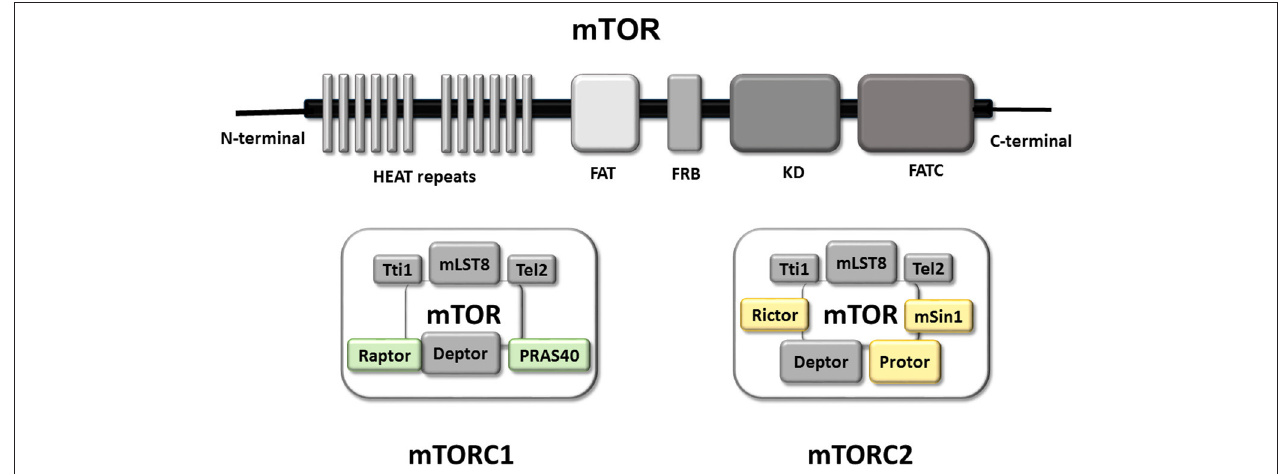
FIGURE 1 | mTOR Functional domains and composition of mTORC1 and mTORC2. Graphical representation of the main functional domains of mTOR protein. mTOR contains at C-terminal a FAT domain (FATC), the kinase domain (KD), a rapamycin binding domain (FRB) and a transactivation domain-associated protein domain (FAT). The N-terminal domain is composed by a HEAT repeats site with a key role in the interaction with regulatory proteins permitting the formation of mTOR complex (mTORC1 right and mTORC2 left). Representation of the mTORC1 and mTORC2 complex Both complex are formed, so far, by five common proteins and two/three specific proteins. The common components of both complexes are in gray (Tti1; mLST8; Tel2; Deptor in gray). Whereas Raptor and PRAS40 are present in mTORC1 (green), and Rictor, Protor and mSin1 are part of mTORC2 (yellow).